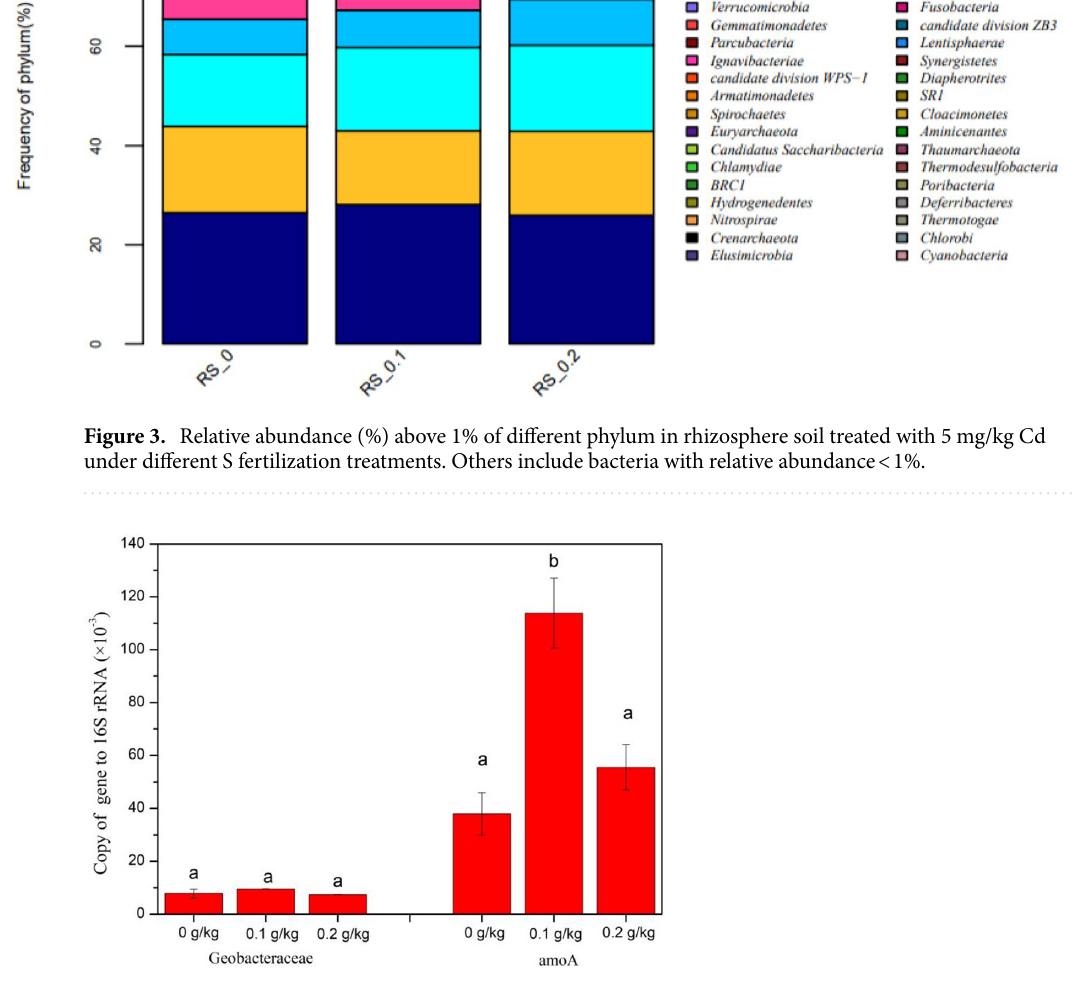
Figure 4. Relative gene abundances of geobacteraceae and amoA in rice rhizosphere soil treated with 5 mg/kg Cd under different sulfur fertilizer treatments. Different capital letters within relative abundances represents a significant difference among different S levels at P <